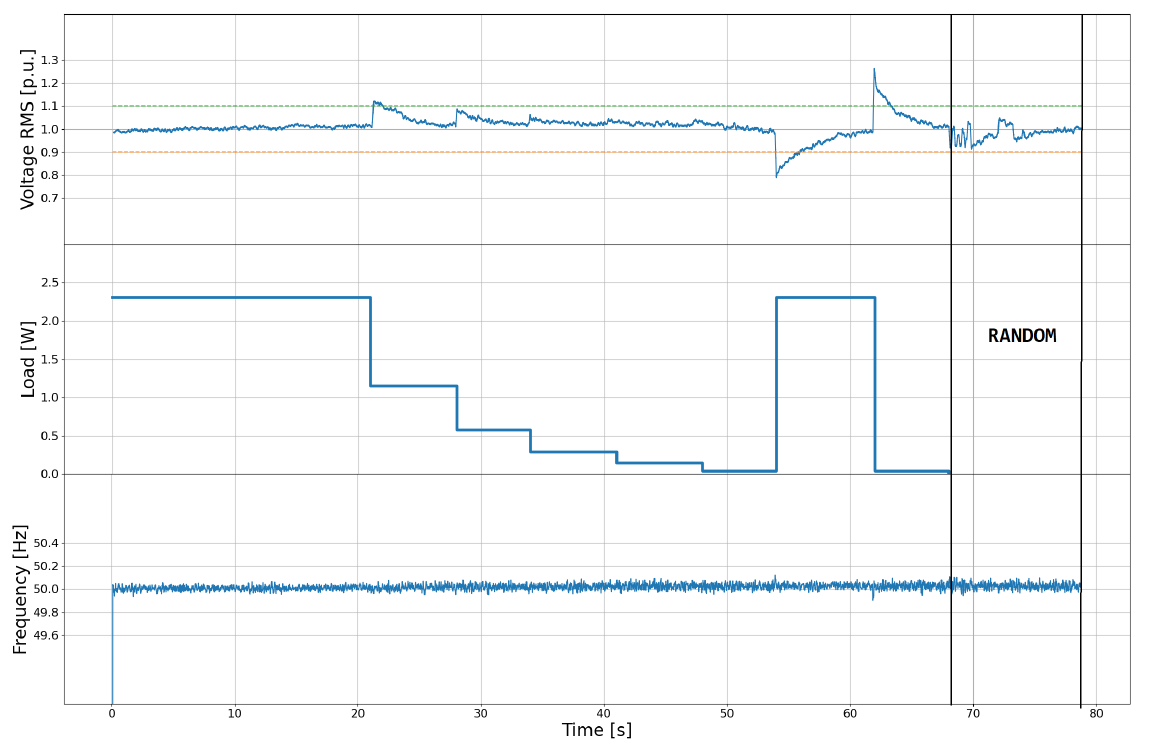
Figure 12. Electrical quantities of switching load test. Table 1. Resistance values of variable load at the